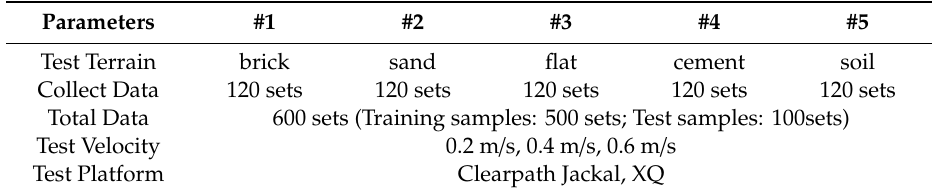
Table 1. Setting of experimental parameters.